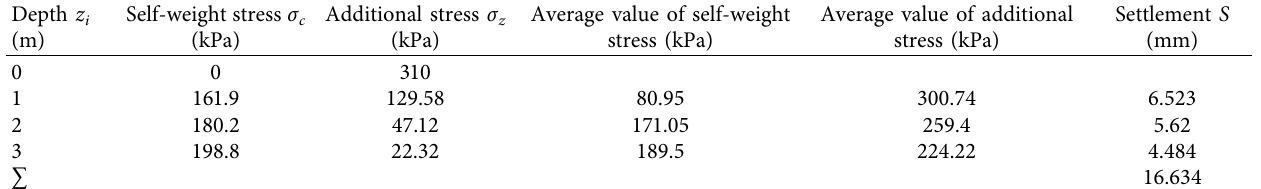
Table 6: Settlement calculation table.